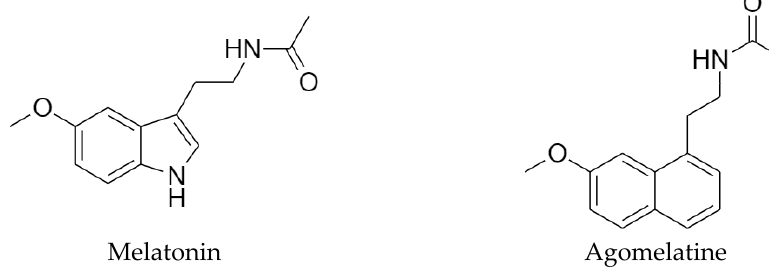
Figure 1. 2D structure of melatonin and its agonist agomelatine.